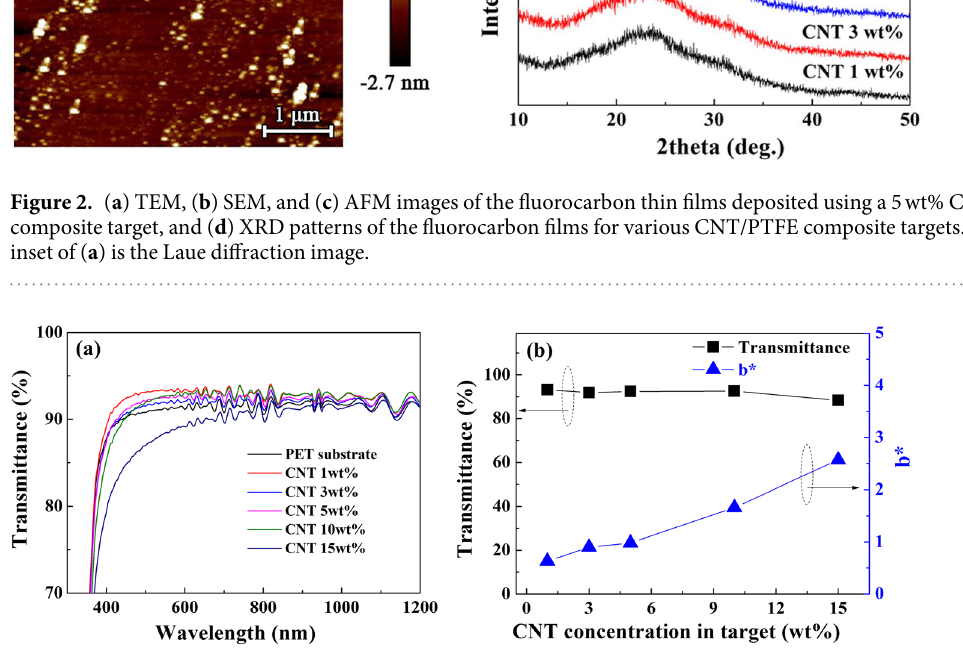
Figure 3. ( a ) The transmittance spectra in the wavelength range from 300 to 2400 nm, and ( b ) the optical transmittance at 550 nm and the yellow index of the fluorocarbon films deposited using CNT/PTFE composite